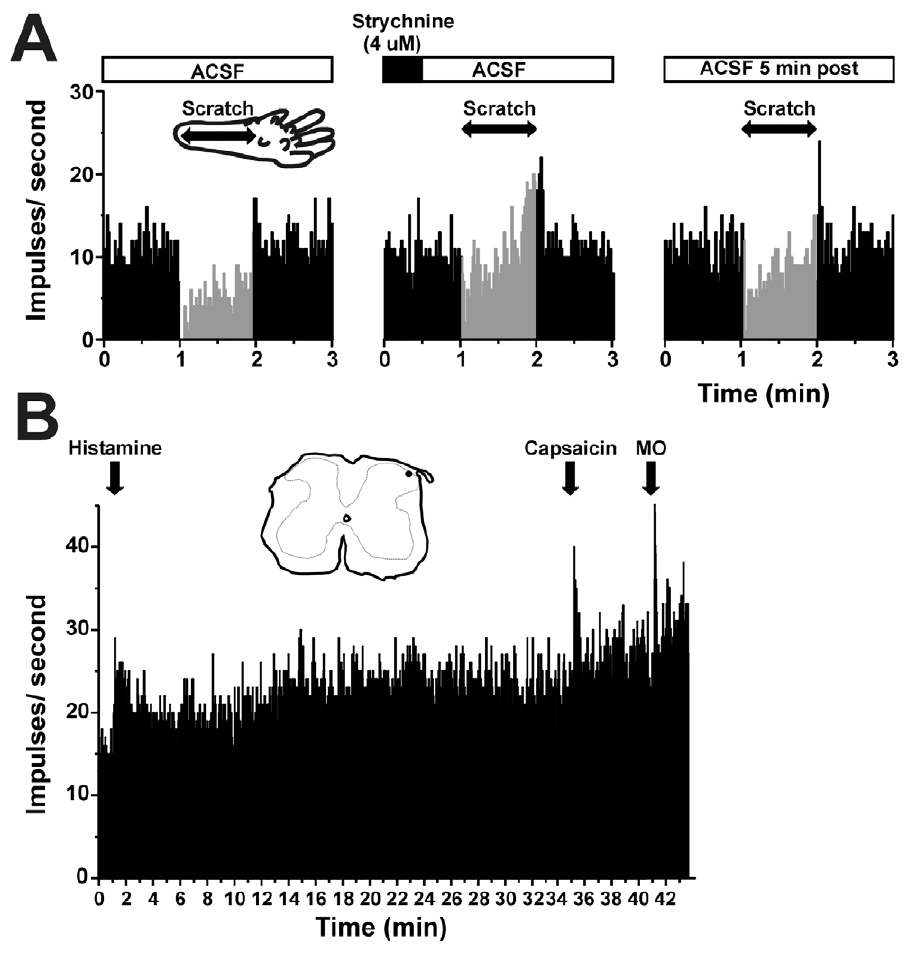
Figure 1. Scratch-evoked inhibition of spinal neuronal firing is blocked by strychnine. A: Shown are peristimulus-time histograms (PSTHs; bins: 1 sec) of a superficial dorsal horn unit’s ongoing firing. The gray portion of the PSTH indicates the time that the scratch stimuli were applied. The left-hand PSTH shows that under control conditions of spinal superfusion with artificial cerebrospinal fluid (ACSF; upper bar), repetitive back-andforth scratch movements across the ventral hindpaw markedly depressed firing. The inset shows the 60-sec duration of scratching (arrows) on a drawing of the hindpaw indicating the direction of scratch motions. When strychnine was delivered by spinal superfusion for 30 sec (middle PSTH; black bar above), scratching was much less effective in reducing neuronal firing. The right-hand PSTH shows partial recovery of scratch-evoked inhibition 5 min post-strychnine. B: PSTH showing response of same unit in A to intradermal injection of histamine (arrow; 50 m g/ m l). Note the rapid and sustained increase in firing rate. The unit also responded phasically to intradermal injection of capsaicin (35 m g/ m l) and topical application of mustard oil (MO). Inset shows a spinal cord section with the histologically recovered recording site ( N ) in lamina I.